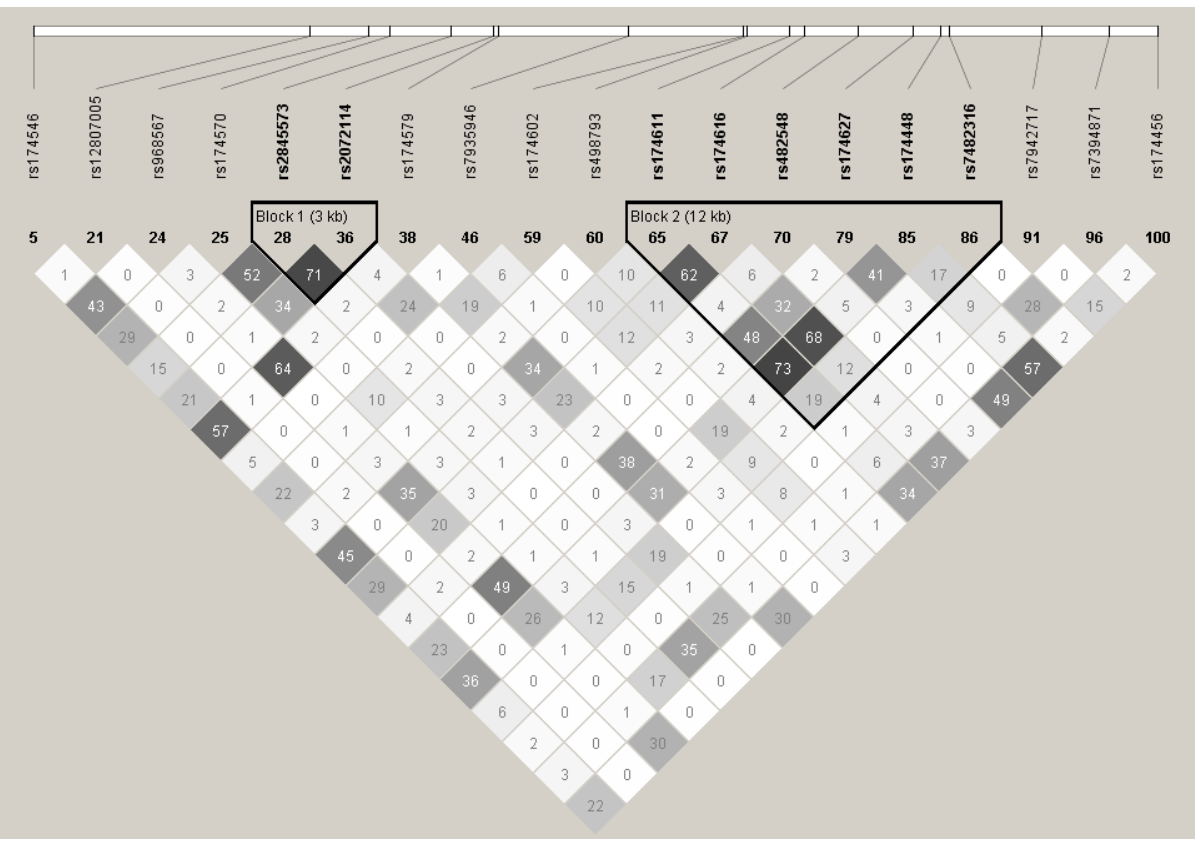
Figure 1. Linkage disequilibrium (LD) plot of SNPs of the fatty acid desaturase ( FADS ) gene cluster.